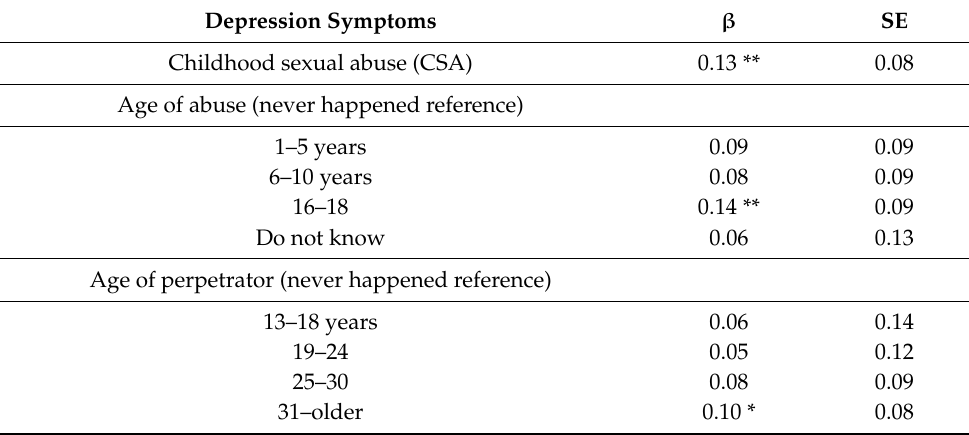
Table 3. Bivariate regression with study variables on depression symptoms (N =